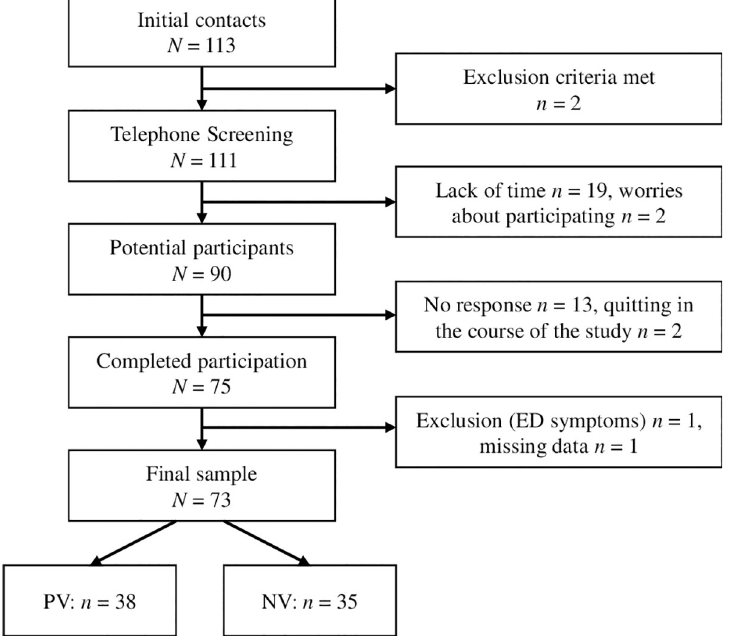
Fig 1. Participant flow chart. PV = Positive Verbalization, NV = Negative Verbalization.